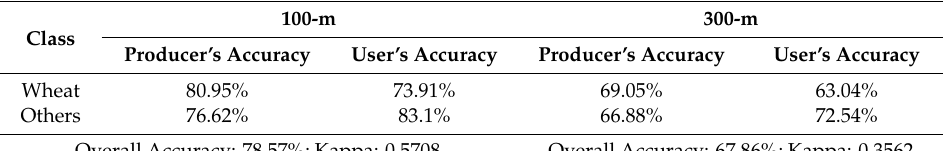
Table 8. Classification accuracies of the 300-m and 100-m time-series data at Site 2.